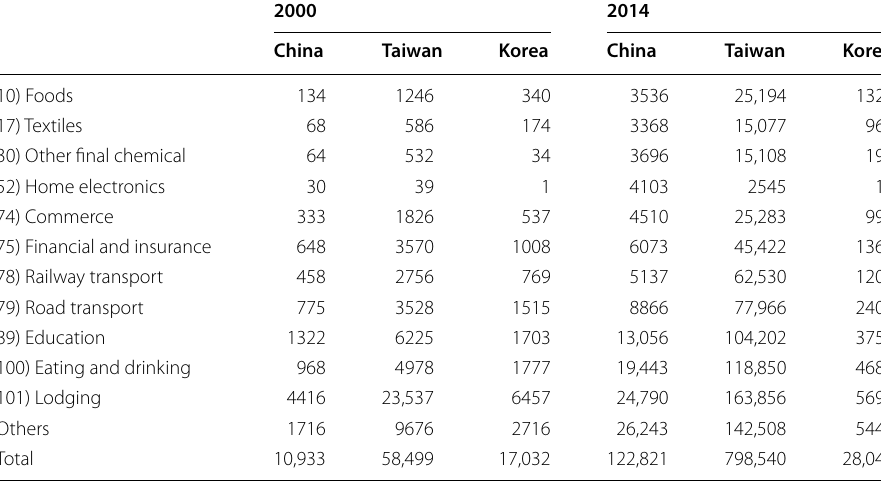
Table 5 Repercussion effects of visitor’s consumption on value added (Unit: 10 5